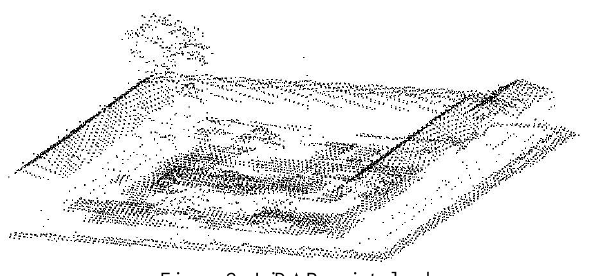
Figure 2. LiDAR point cloud